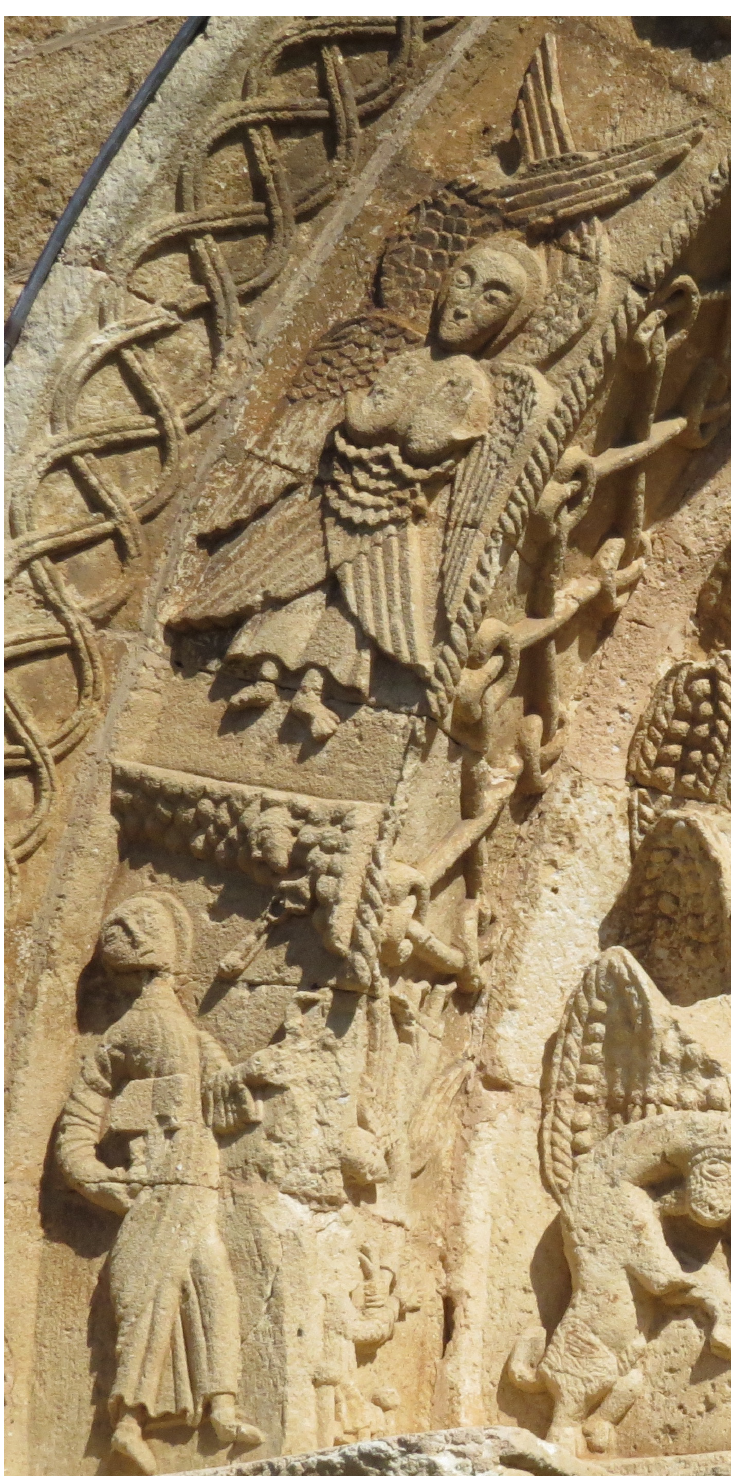
Figure 6. Prophet Isaiah and seraph, detail of archivolt, west façade, Saint-Martin Church , 12th c., Besse, Dordogne, Nouvelle-Aquitaine, France. ©Author.